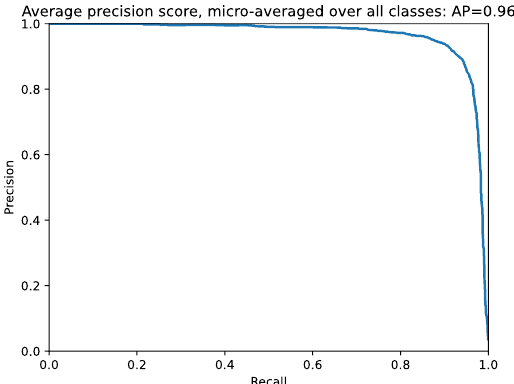
Figure 10. Precision-Recall curve for the tiered model with the average precision score micro- averaged over all classes.